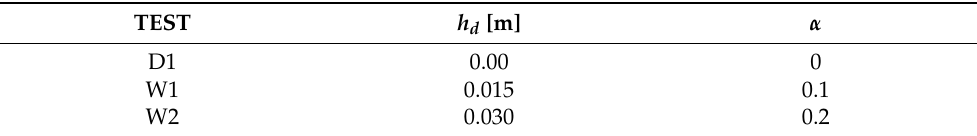
Figure 1. Schematic view of experimental setup and plate removal mechanism: ( a ) Plan and ( b ) A- A cross-section. Lengths are in [cm].